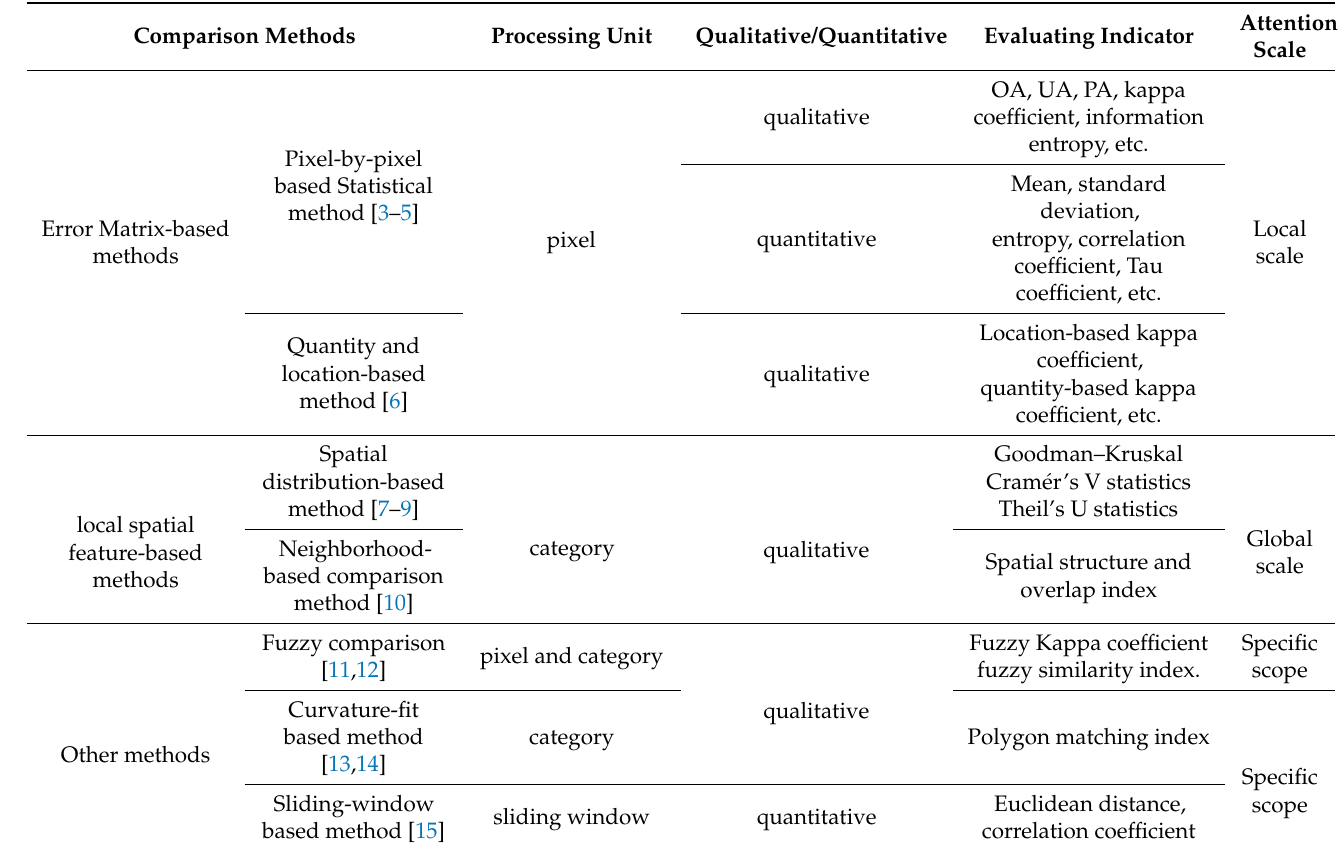
Table 1. Relative comparison methods.